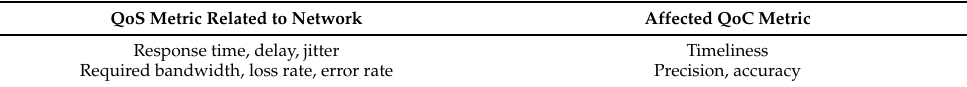
Table 7. QoC metrics affected by different QoS metrics related to the